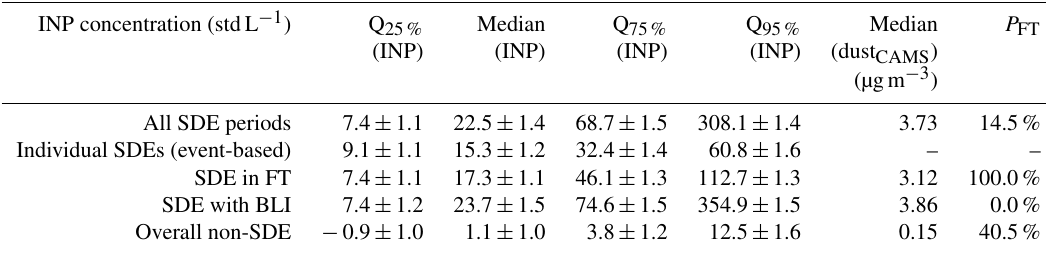
Table 1. Statistics of the analyzed time period with the 25th (Q 25% (INP)), 50th (median), 75th (Q 75% (INP)), and 95th (Q 95% (INP)) percentiles; the median dust CAMS concentration; and the fraction of all measurements in the FT ( P FT ). “All SDE periods” assesses the collective INP measurements during all SDEs, “Individual SDEs (event-based)” analyzes every single SDE and shows, for example, the median INP concentration of all single SDE medians. All INP concentrations are in units ofINPstdL − 1 . Uncertainty indicates a 1 σ counting uncertainty of